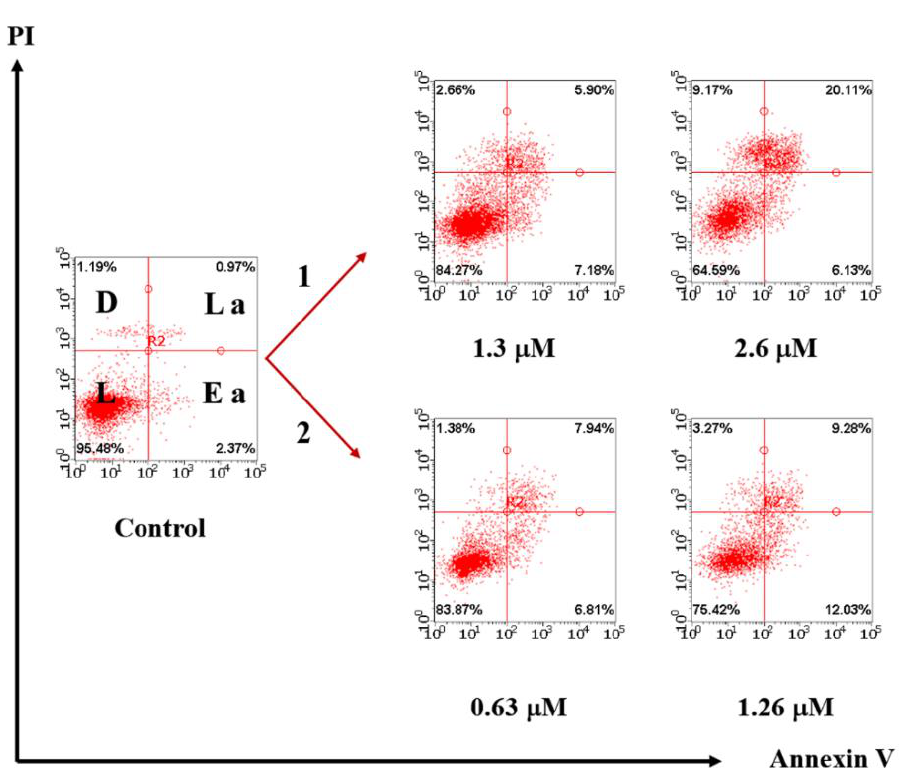
Figure 6. Flow cytometry analysis of M-HeLa cells treated with different concentrations of Au 2 Re 6 -S (1) and LSZ-Au 2 Re 6 -S (2) after Annexin V and PI staining. The values are presented as the mean ± SD ( n = 3): * p < 0.01 vs. the control group. L—living cells; D—dead cells; E. a.—early apoptotic cells; L. a.—late apoptotic cells.